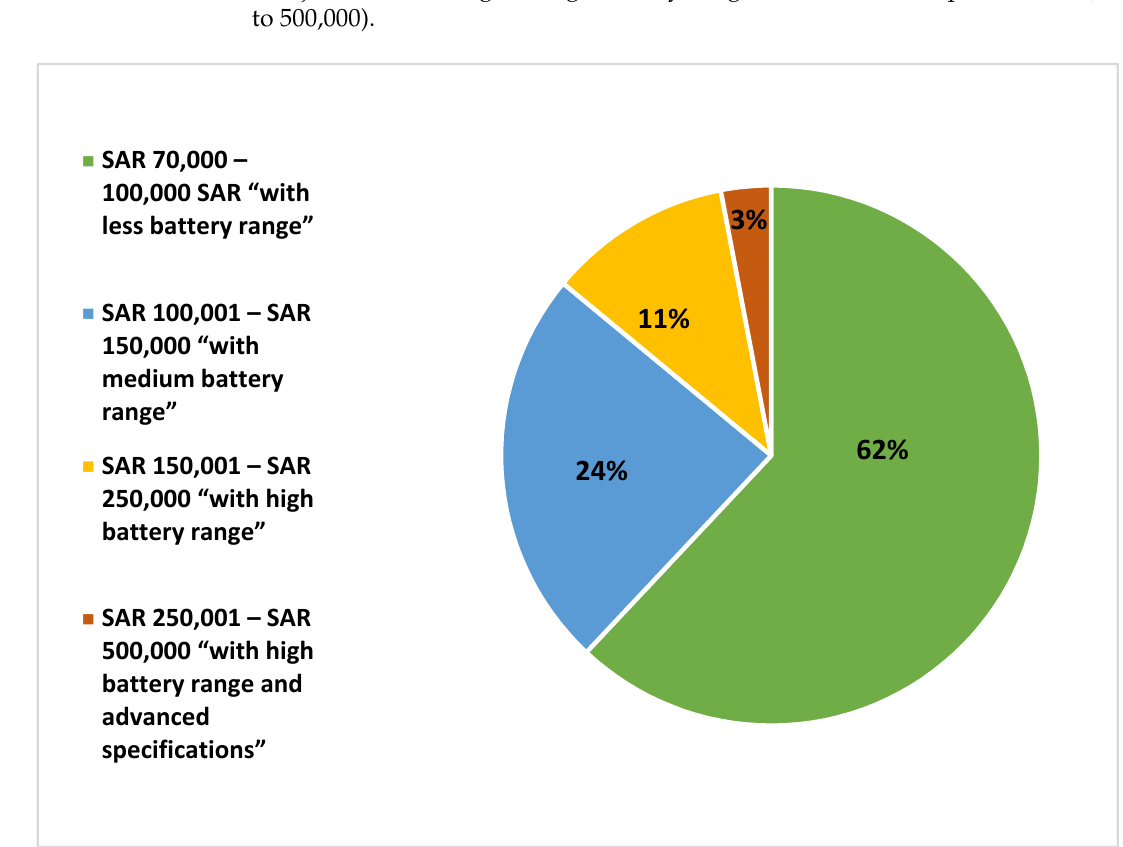
Figure 5. Respondents’ EV price preferences in terms of battery range.